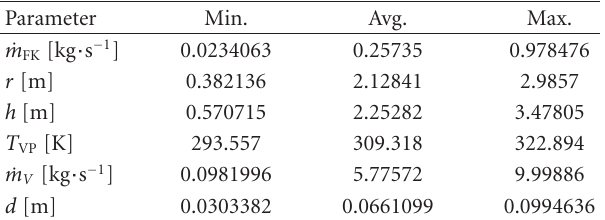
Table 13: Estimated parameters for SA Elitism.